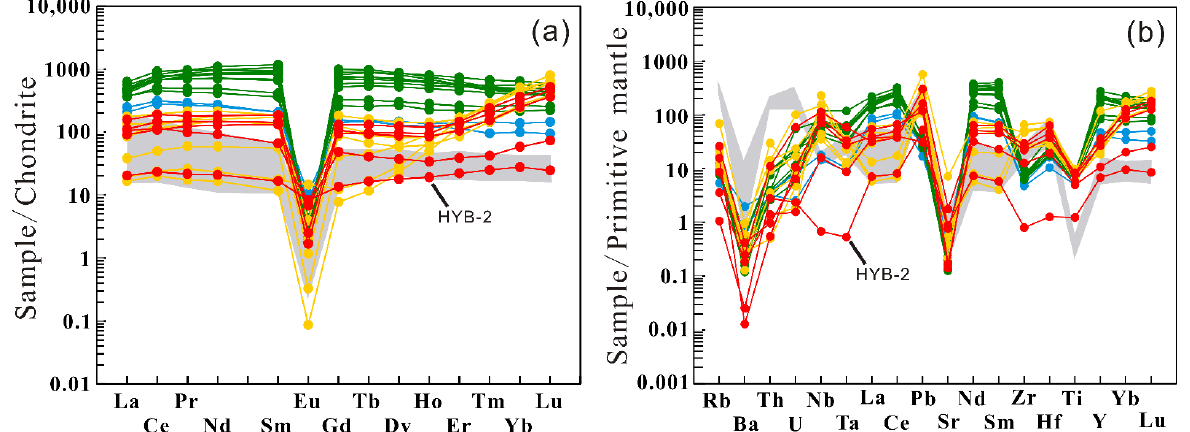
Figure 6. Chondrite-normalized REE patterns ( a ) and primitive mantle-normalized trace element variation patterns ( b ) of amphiboles and granites in the Huangyangshan deposit. The normalizing values for the REEs and trace elements are from Sun and McDonough [59]. The yellow, red, blue, green lines and the shadow parts represent the trace element data of Type-I, Type-II and -III, Type-IV, Type-V and granites, respectively. The granites data are from Sun et al. [19].